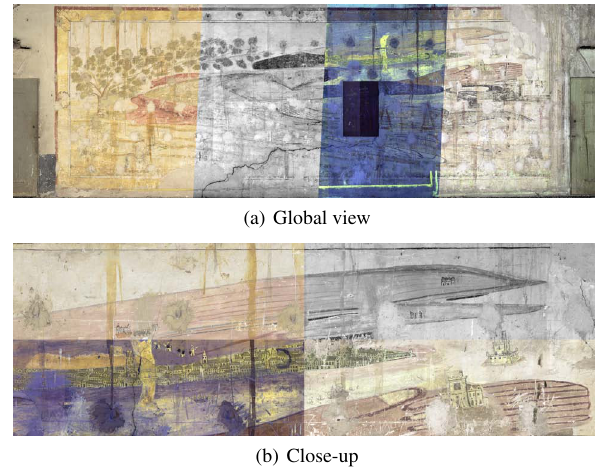
Example of multi-spectral orthophoto (VIS/IR/UVF/Composite), Anamorphosis case-study